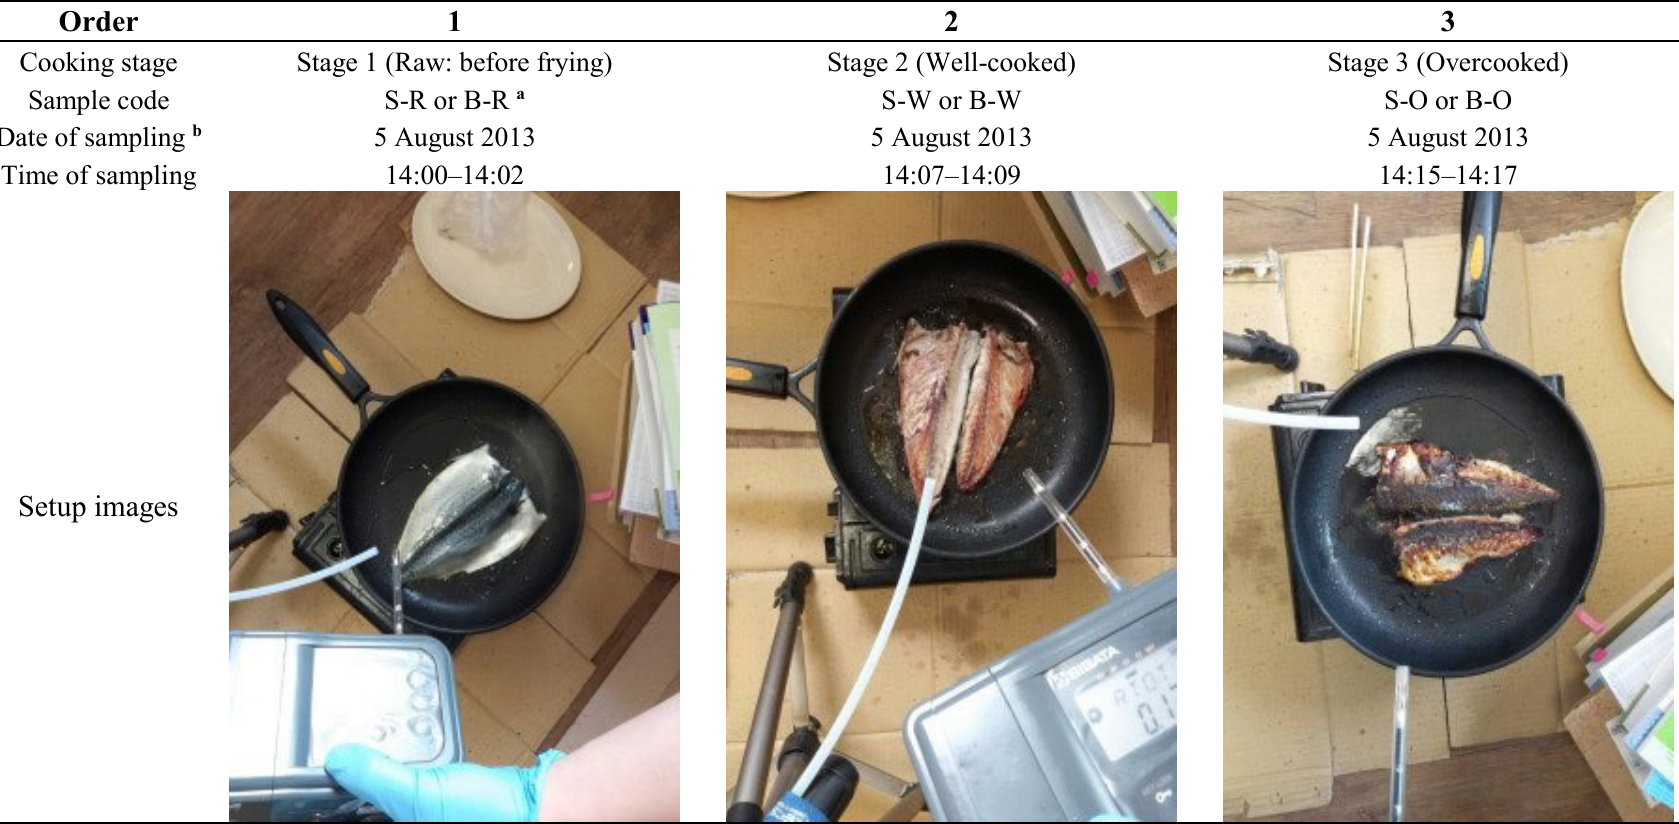
Figure 1. Basic information on mackerel frying conditions for the sample collection (310 g) in this